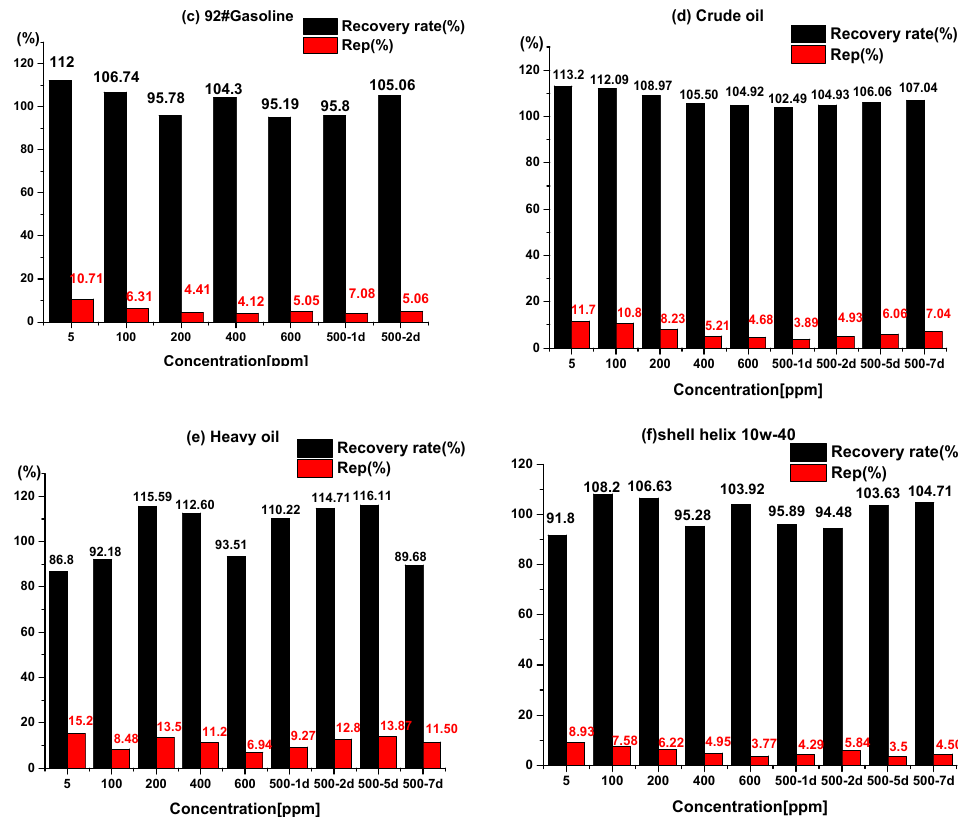
Figure 7. The predicted results of test samples and weathering samples based on the CEM database. oils were between 86.8% to 116.11%, and the relative errors of predictions ranged from 2.09% to